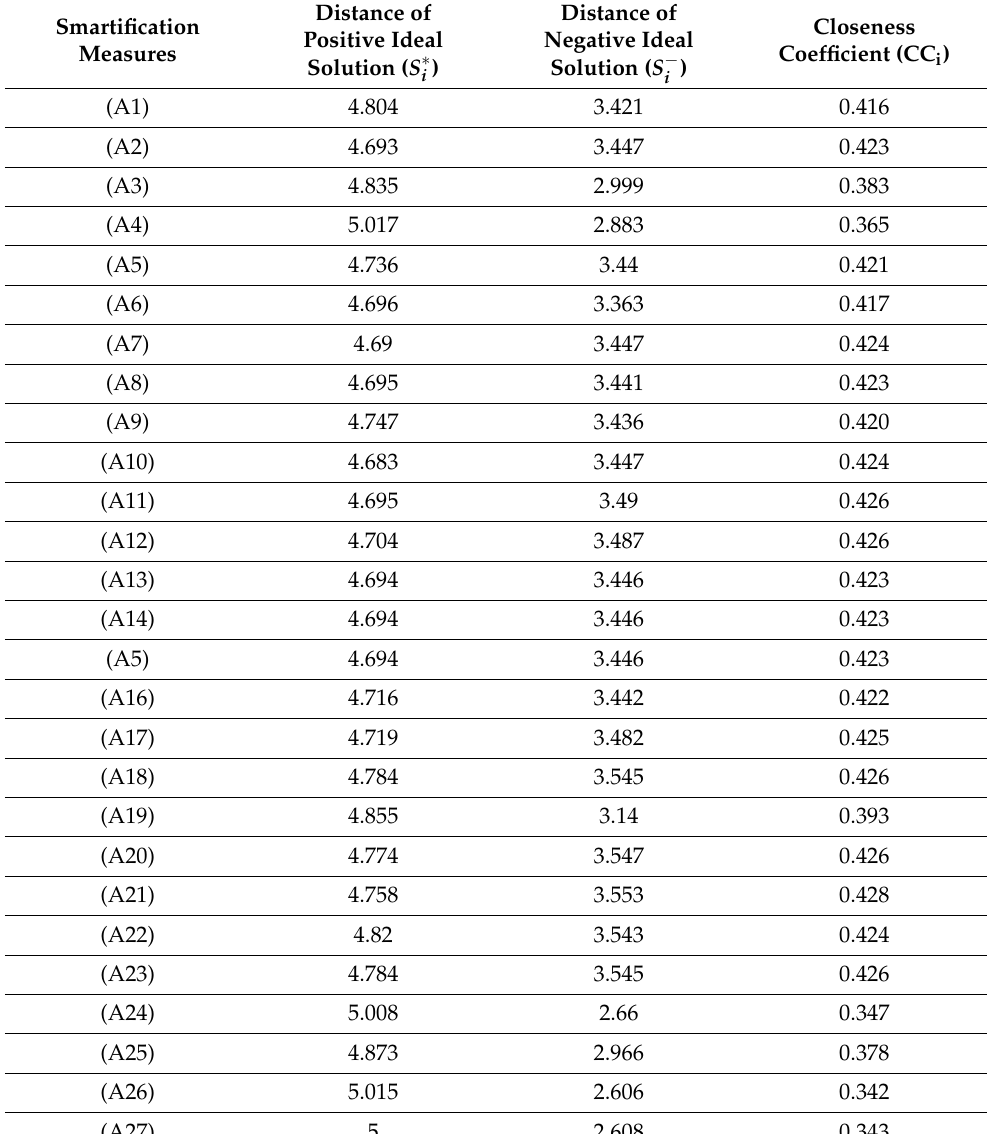
Table 6. Distance of positive and negative ideal solution and closeness coefficient for each smartifica- tion